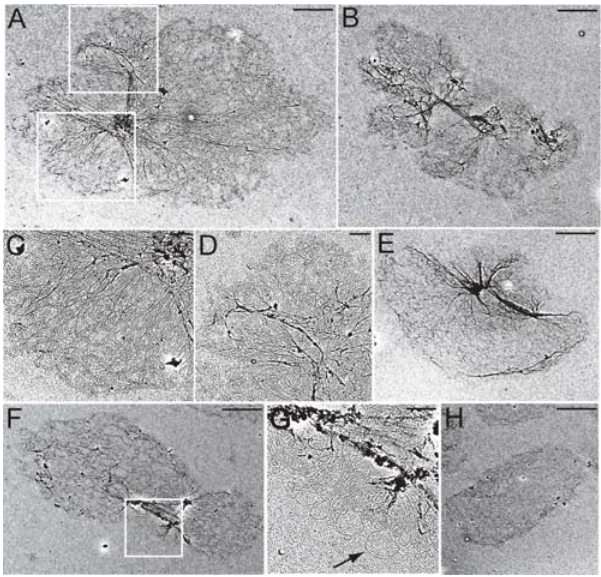
Figure 4. Electron microscopic examination of kDNA networks from the control and TbHslV RNAi cells. Methods were described by [38]. ( A, B, E, F ) kDNA networks from cells after 7 days of TbHslV RNAi. ( H ) A kDNA network from an un-induced control cell. ( C, D ) Enlargements of the network in A , corresponding to the areas outlined in white framed boxes. ( G ) Enlargement of the network in F framed in a white box. The arrow in G indicates a maxicircle. Scale bars for A , B , E , F , and H , 2 m m and for C , D , and G , 0.5 m m.